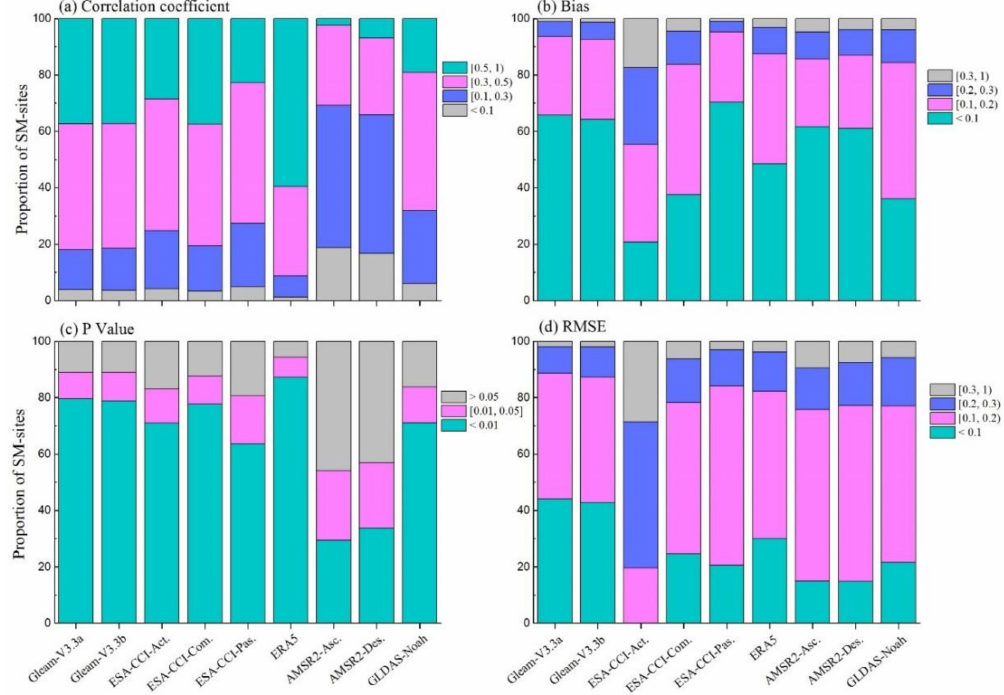
Figure 9. Proportion of SM observation sites in CC ( a ), bias ( b ), p -value ( c ) and RMSE ( d ) between multi-source SM products and in situ ground